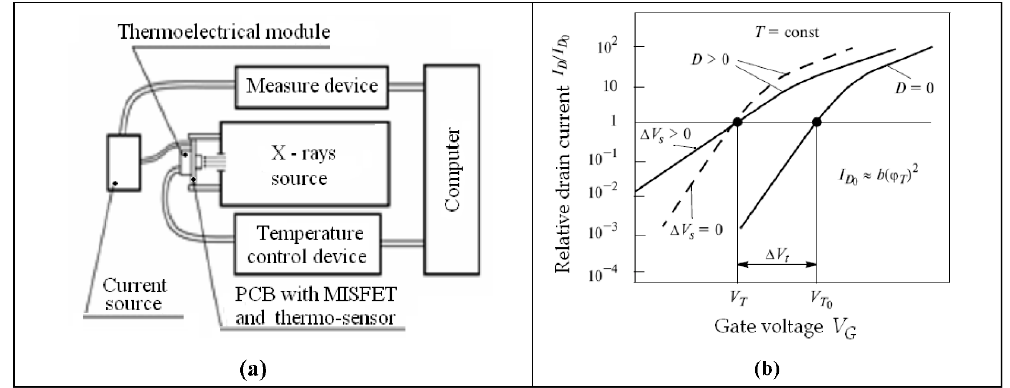
Figure 2. ( a ) The structure of system MERA-3; ( b ) MISFETs’ I – V characteristics before and after